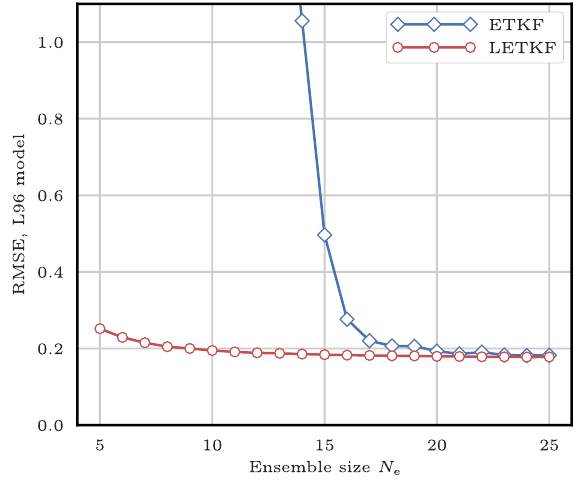
Figure 4. RMSE as a function of the ensemble size N e for the ETKF and the